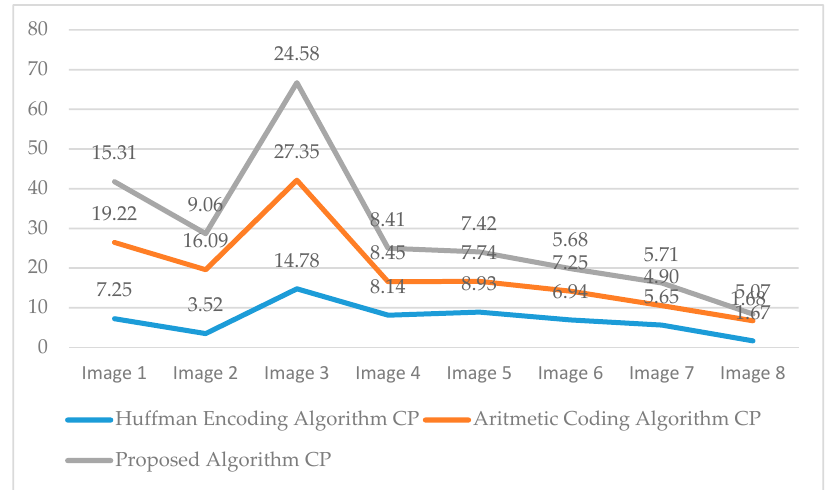
Figure 14. Compression percentage (CP) values of Group 1 images.